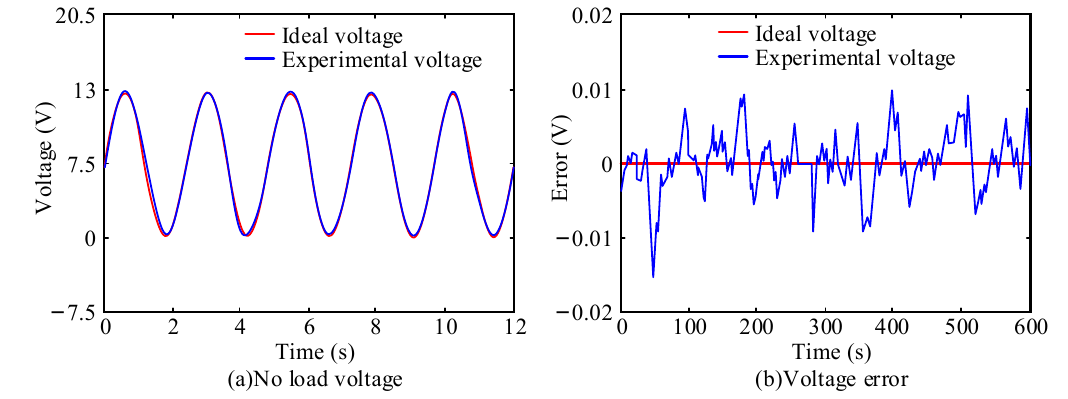
Figure 4. No load discharge test of battery.